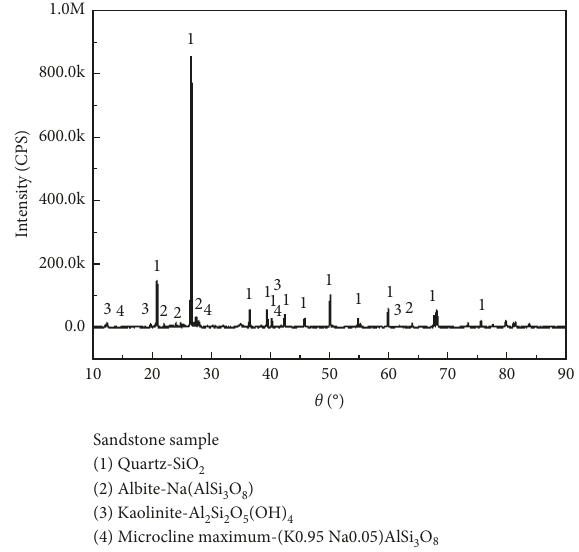
Figure 1: XRD spectrum of sandstone sample (under 20 °